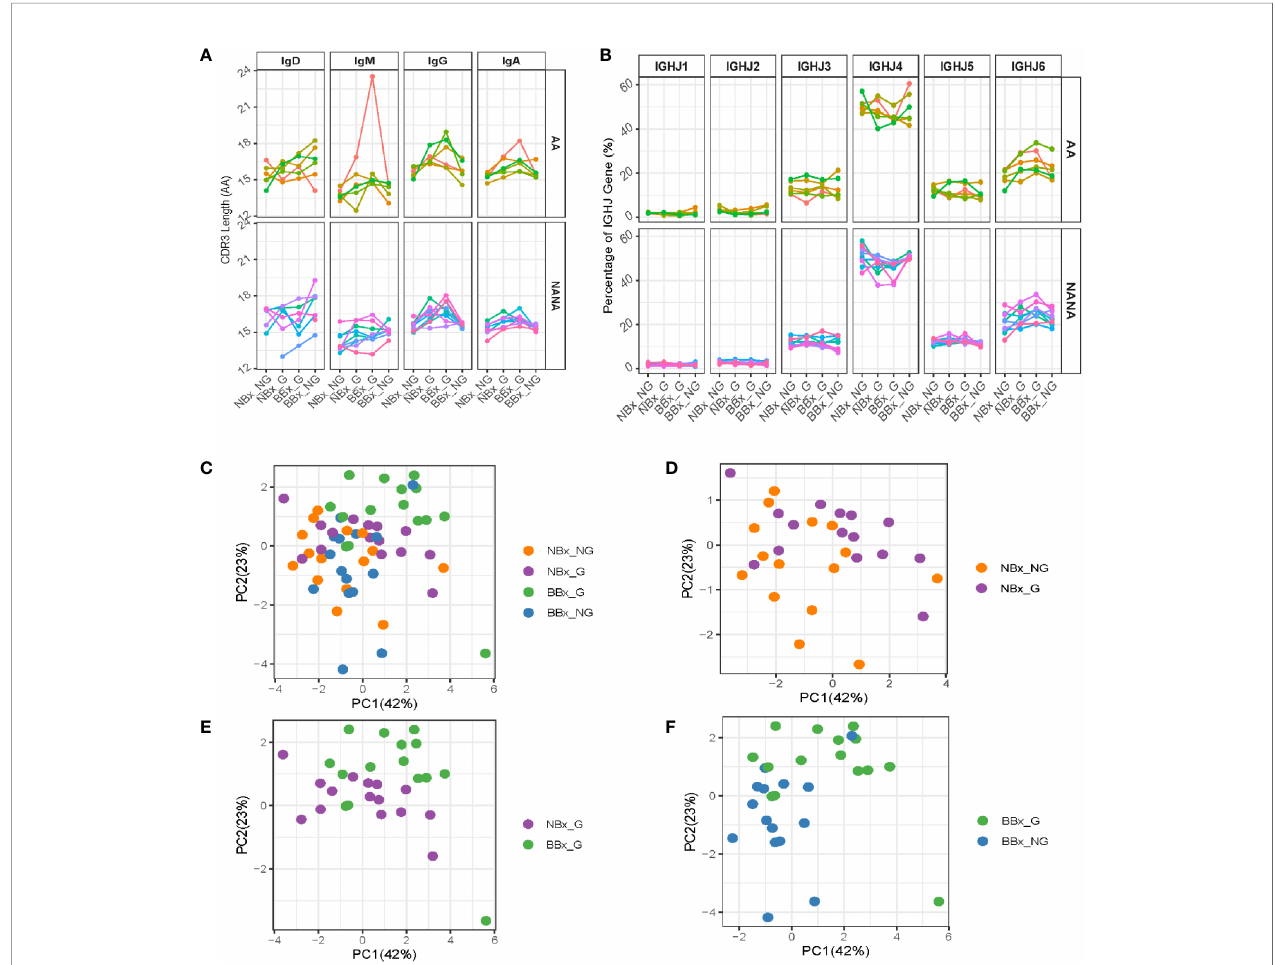
FIGURE 7 | Global clones have longer CDR3 regions with distinct amino acid properties. Sequences from the nasal and bronchial mucosa were divided into groups as described in Figure 6 . (A) The mean lengths (in amino acids) of the CDR3 region of sequences belonging to each group were calculated for each individual (each line represents an individual, colored the same way as panel (B) and Figure 6 ). (B) The IGHJ-gene usage in sequences of the four sample types was plotted for atopic asthmatics (AA) and non-atopic, non-asthmatic controls (NANA) separately for each individual (each line represents an individual, colored the same way as panel (A) and Figure 6 ). Eight different properties of the CDR3 amino acids were calculated (see Supplementary Figure 7 ) and summarized in PCA plots. Each unique sequence was included with the weight of one. The PCA plots were for (C) the four sequence subsets together (non-global nasal sequences (orange), global nasal sequences (purple), global bronchial sequences (green) and non-global bronchial sequences (blue), (D) non-global (orange) versus global (purple) nasal sequences, (E) global nasal (purple) versus bronchial (green) sequences and (F) global (green) versus non-global (blue) bronchial